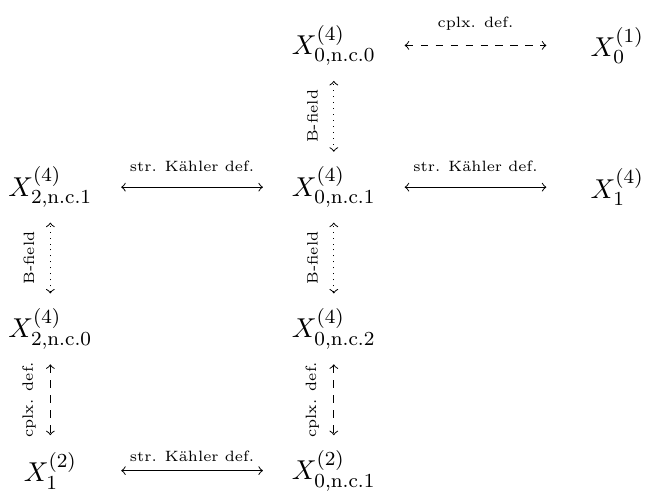
Figure 9 . The inequivalent geometries X (4) , i = 0 , . . . , 2 from the Z 4 Tate-Shafarevich group of i the smooth genus one fibered Calabi-Yau X (4) , as well as their non-commutative resolutions and 1 smooth deformations. Deformations of the stringy Kähler structure, the complex structure or a change of a flat torsional B-field are respectively indicated by solid, dashed and dotted arrows.